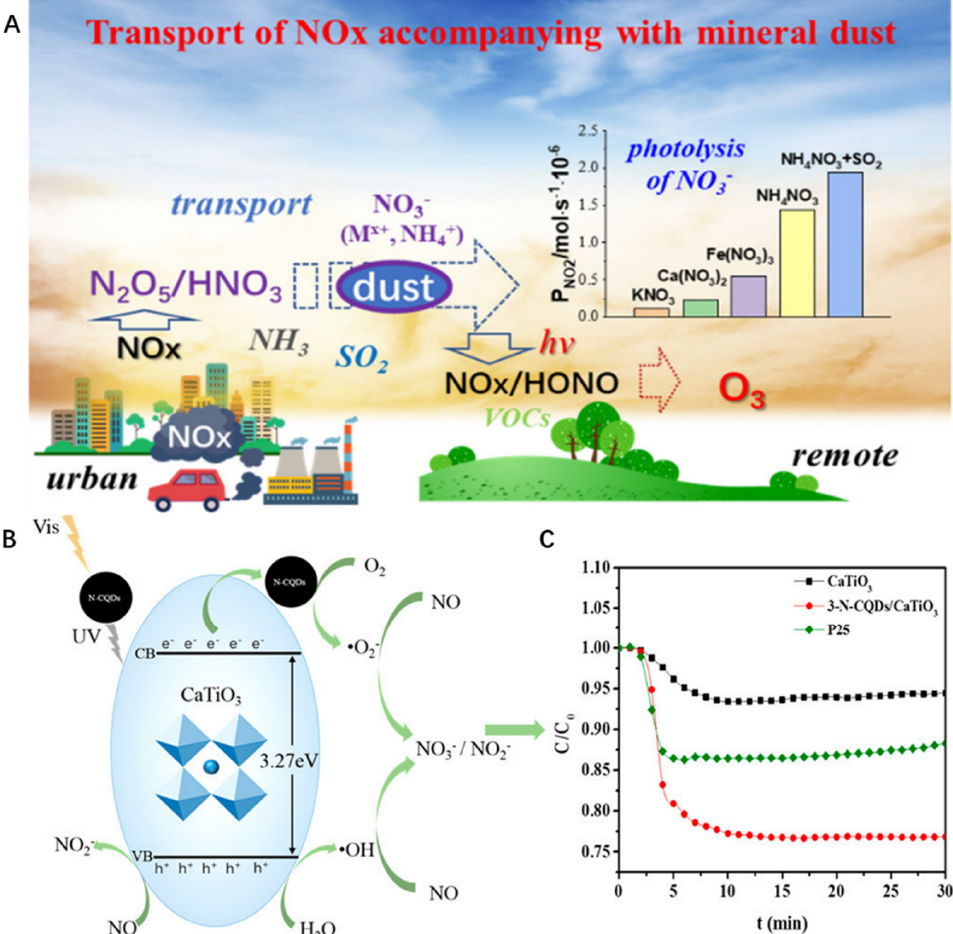
Figure 3. ( A ) The process of photooxidation of nitrates by minerals, copyright 2021 American Chemical Society. ( B ) Mechanism diagram of photocatalytic oxidation of nitrogen oxides of 3 − N − CQDs/CaTiO 3 composite, copyright 2018 American Chemical Society. ( C ) Removal efficiency of nitrogen oxides by mineral photocatalytic oxidation, copyright 2018 American Chemical Society.